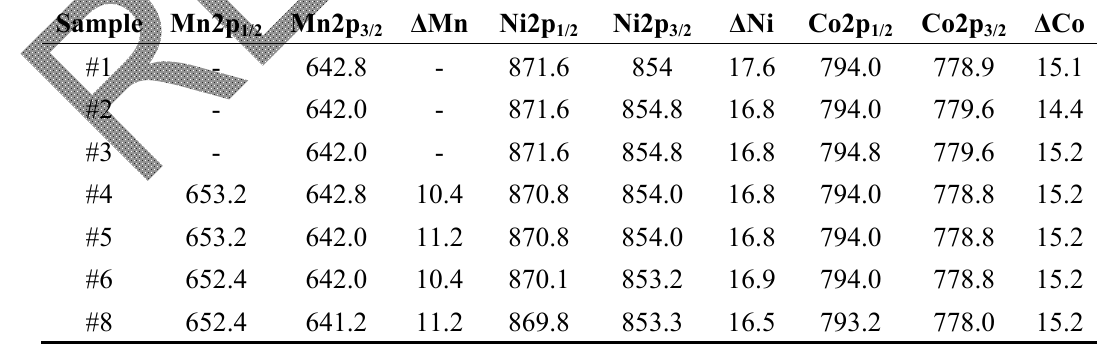
Table 3. Summary of XPS results of the compositions